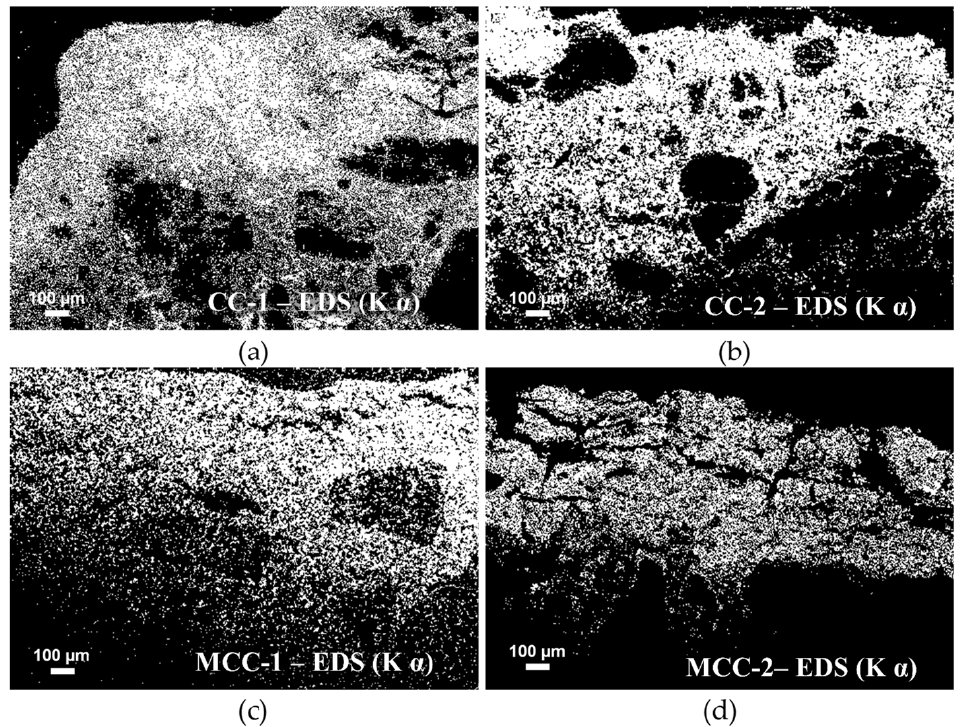
Figure 5. K distribution in the surface layer of castables after 3 cycles of alkali attack at a temperature of 1100 °C seen in EDS maps: ( a )—CC-1; ( b )—CC-2; ( c )—MCC-1; ( d )—MCC-2.